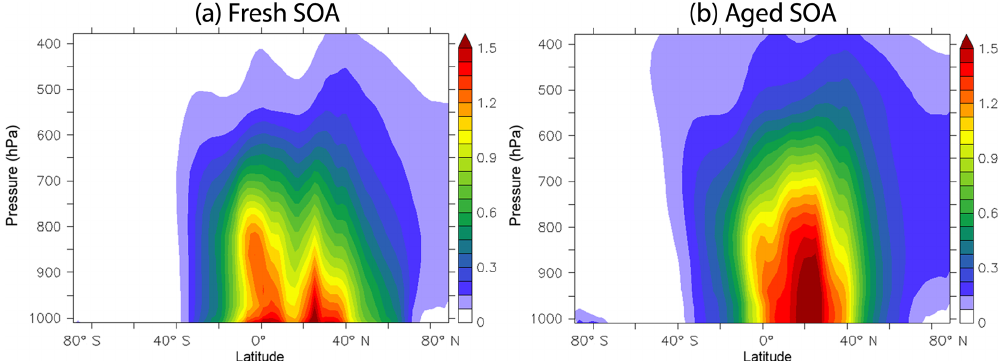
Figure 6. Predicted average zonal concentration (in µgm − 3 ) of (a) fresh SOA and (b) aged SOA during the years 2001–2010.